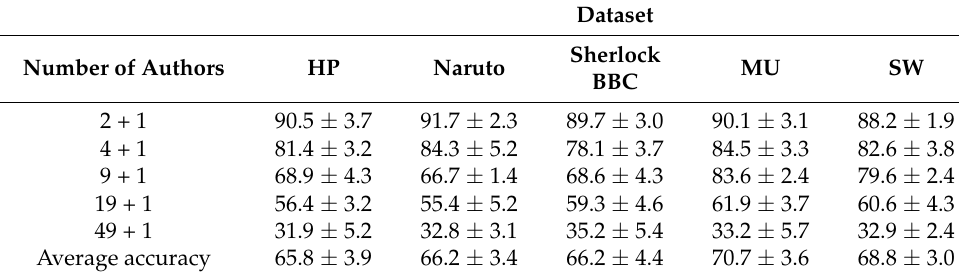
Table 16. Method based on Euclidean distance for in-group classification.